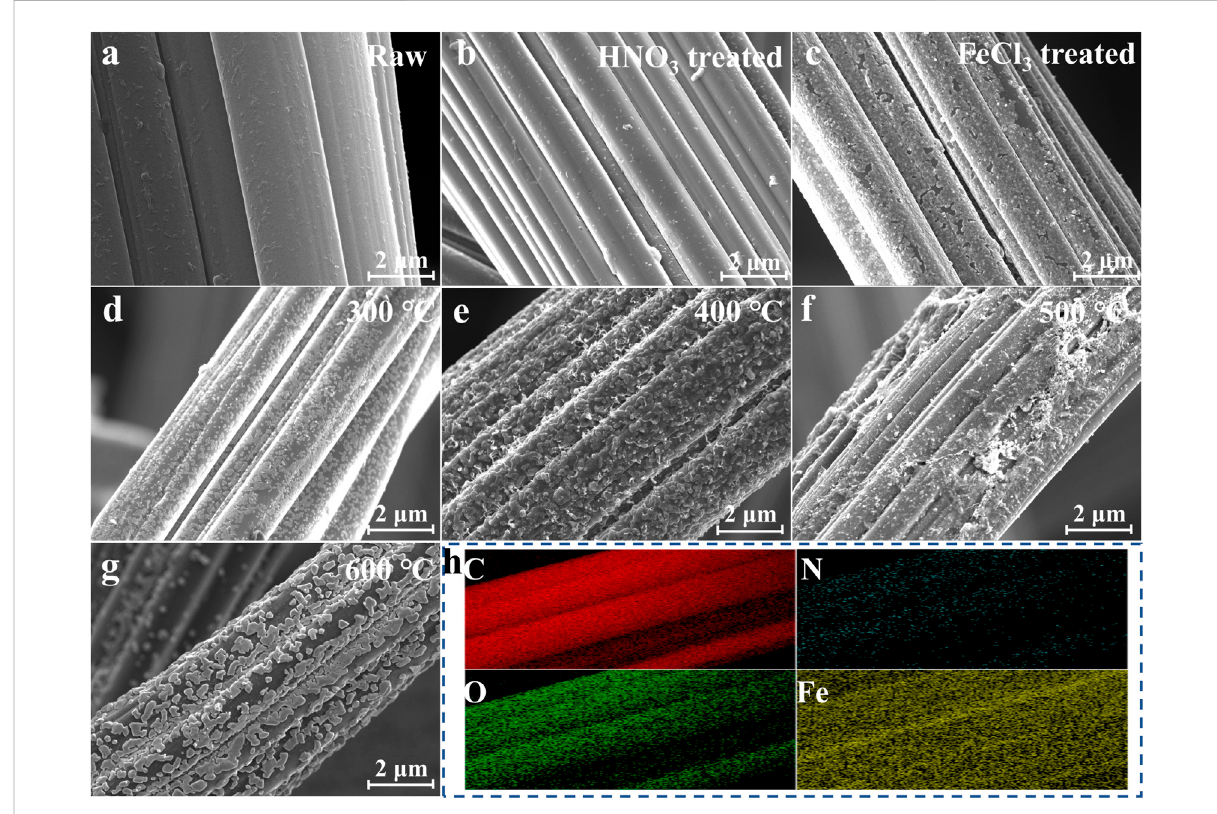
SEMofA@Fe-ACFunderdifferentcalcinationtemperature: (A) Raw. (B) ACFtreatedbyHNO 3 . (C) ACFtreatedbyFeCl 3 . (D) 300 ° C. (E) 400 ° C. (F) 500 ° C. (G) 600 ° C. (H) Element mapping of